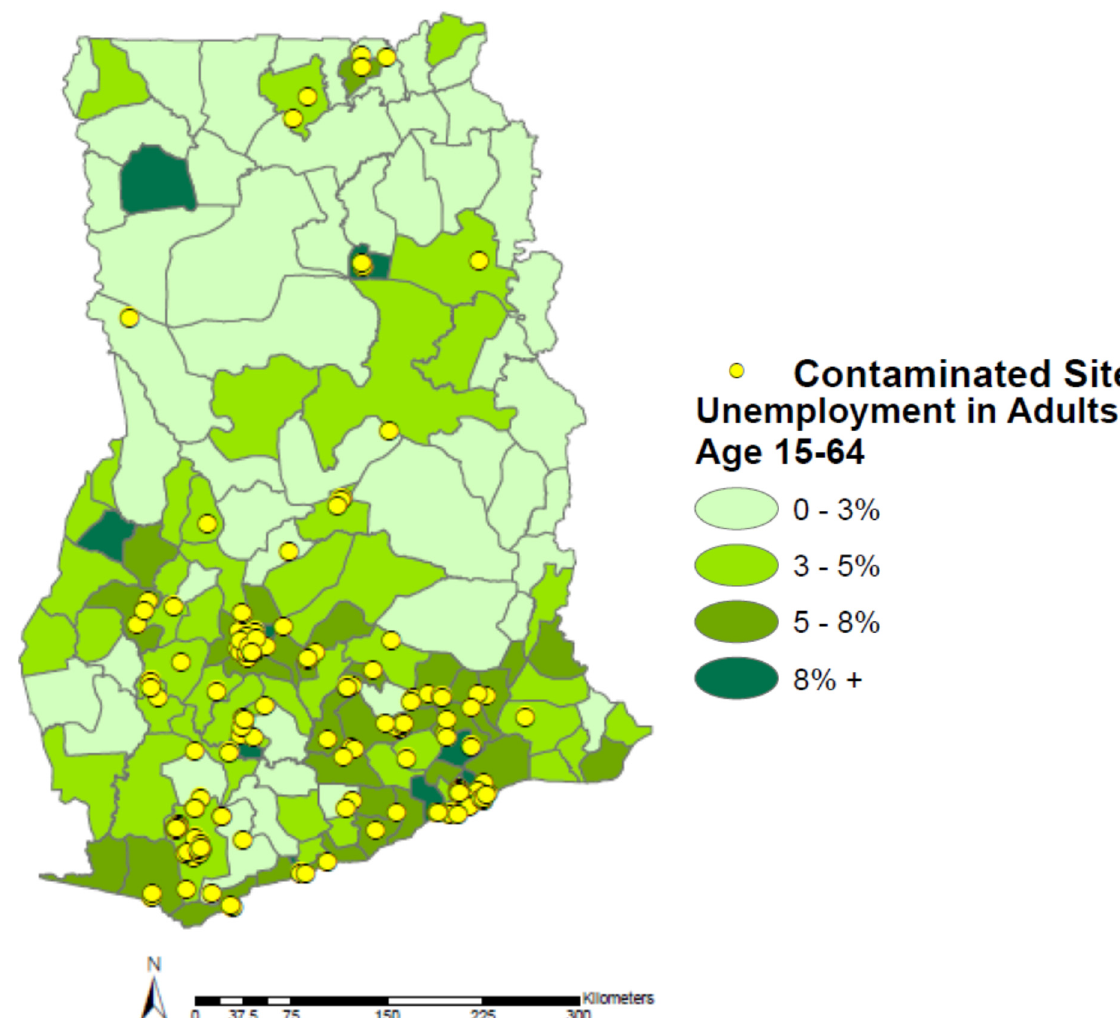
Figure 4. Unemployment in Ghana by administrative district and contaminated